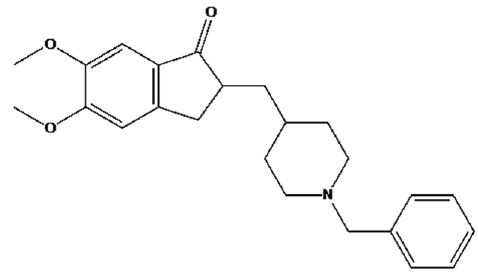
Figure 1. Chemical structure of Donepezil.